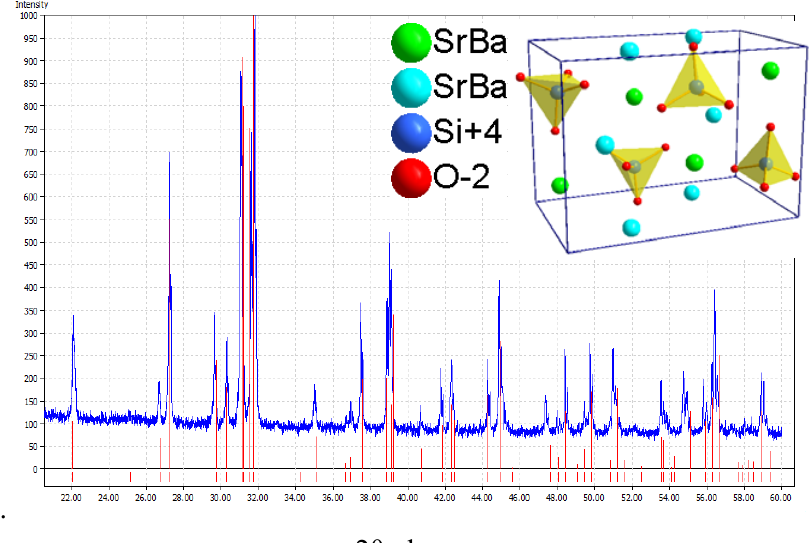
Ba Eu )SiO 1.7 0.2 0.1 4